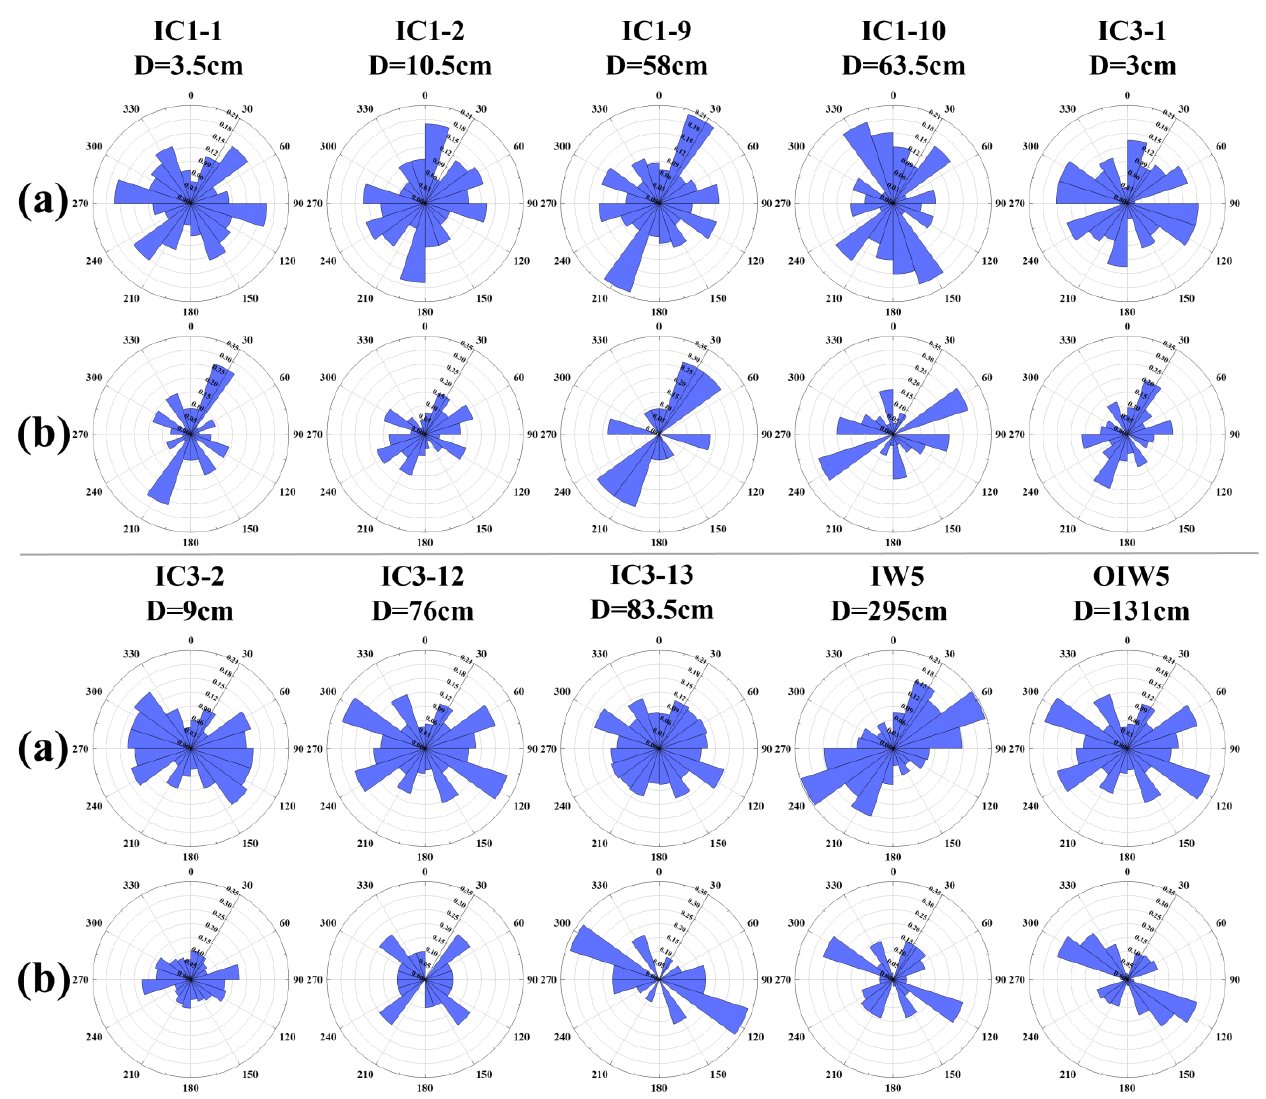
Figure 6. ( a ) Rose diagrams of shape-preferred orientations of ice grains; ( b ) rose diagrams of shape-preferred orientations of bubbles. ‘D’ means depth of the sample.